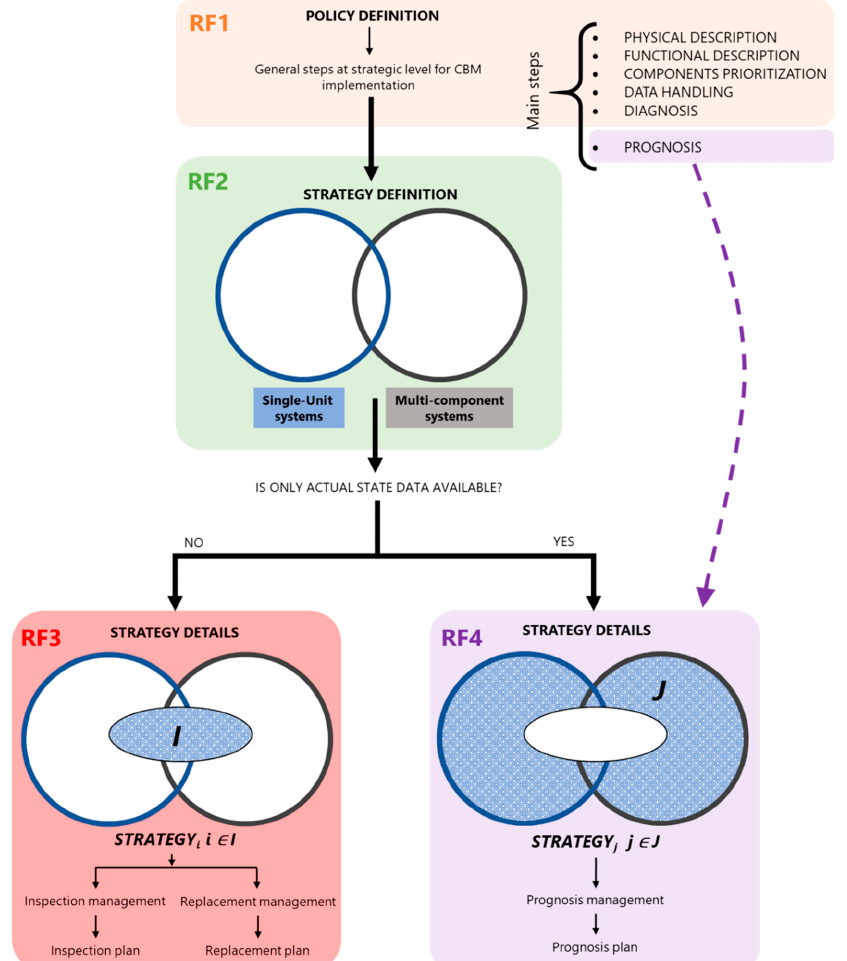
Figure 3. Main research area in condition-based maintenance (CBM).